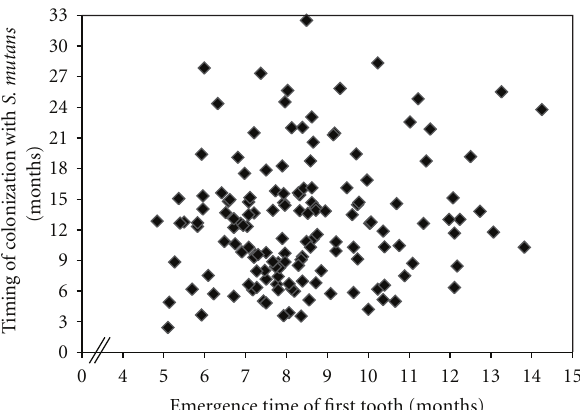
Figure 1: Scatter diagram of timing of colonization against timing of emergence of the first tooth for one randomly selected twin. a significant genetic contribution to phenotypic variation, they are population-based statistics, and caution is needed in extrapolating findings to the individual. For example, even though the estimate of heritability for a given feature may be high, this does not necessarily mean that an environmental intervention cannot have a major e ff ect on the